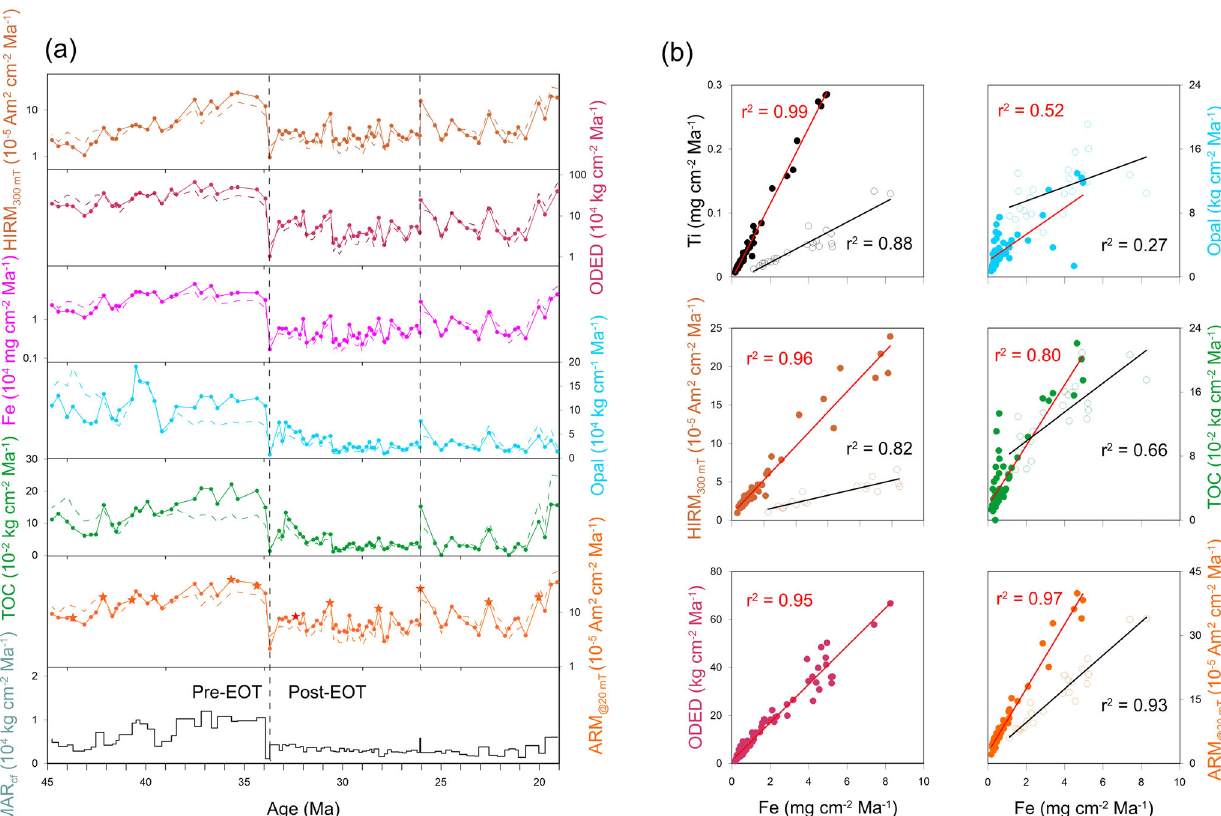
Fig. 3 Dust, productivity, and total Fe record for Site U1333. a Variations of dust, iron, and productivity. Vertical dashed lines mark the boundaries between the Eocene, Oligocene, and Miocene. Each parameter is shown in fl ux and dash line represents the content, HIRM 300mT and ARM @20mT were calculated on a carbonate-free basis. Star symbols in the ARM @20mT panel represent samples selected for FORC and IRM measurements. b Correlations between Fe and terrigenous (ODED, HIRM 300mT , and Ti), and biogenic (ARM @20mT , TOC, and opal) components shown in a ; black and red lines represent pre- and post-EOT correlations, respectively.